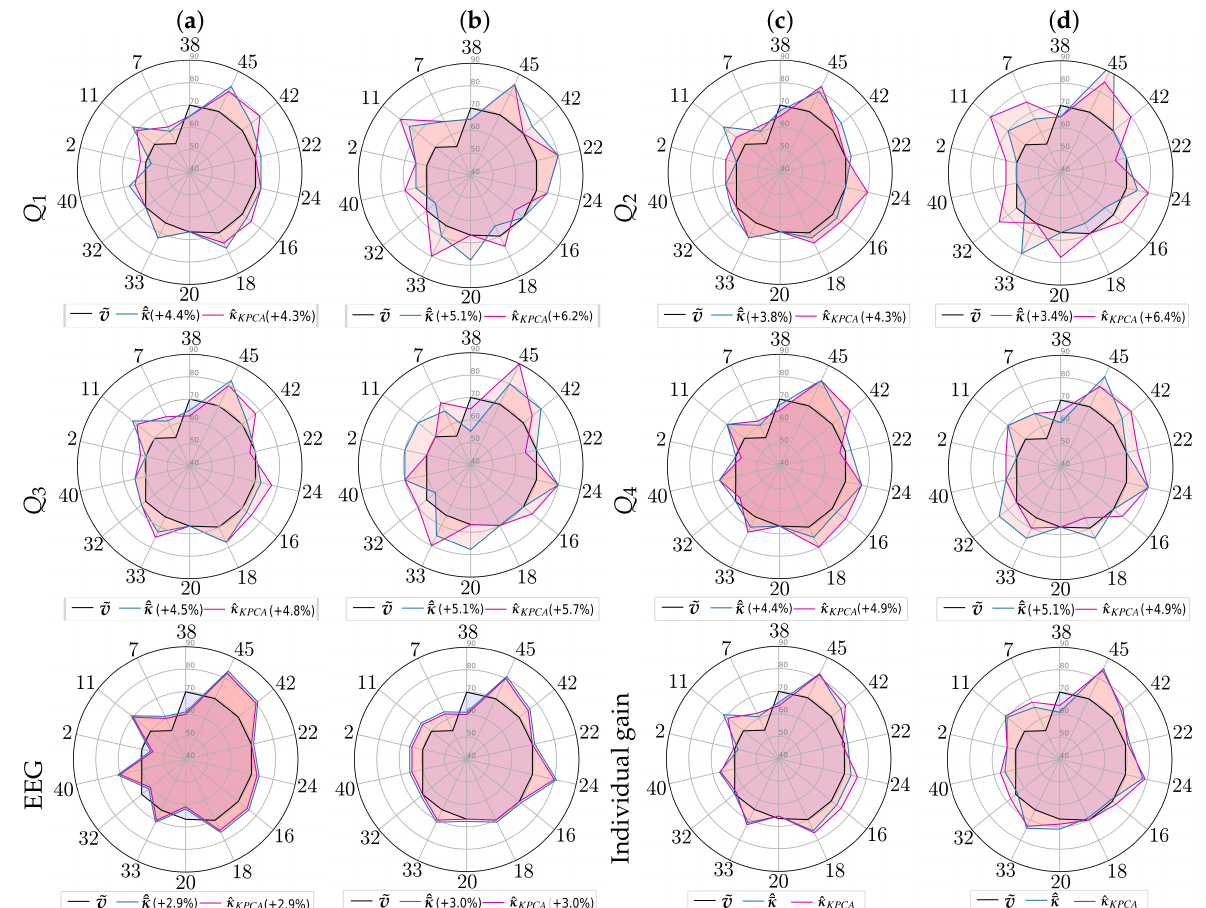
Figure 5. Achieved accuracy by validated strategies of selecting source subjects from Group I. ( a , c ) Single source - single-target , ( b , d ) Multiple sources-single-target . Individual gain reports the average accuracy per subject of questionnaire data Q i and